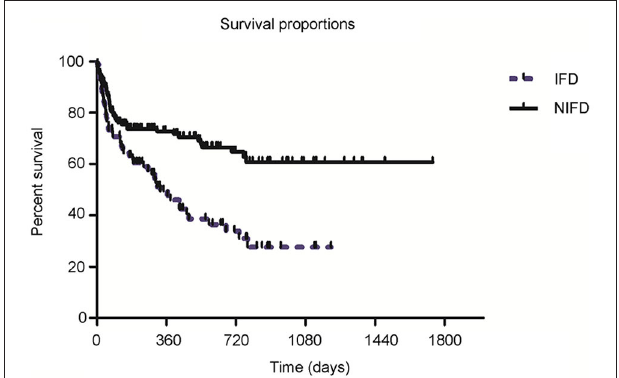
FIGURE 2 | Timing of the diagnosis of invasive fungal disease (IFD). The median time after transplantation at which the diagnosis of IFD was made was 168 days (range, 0–720 days) for invasive pulmonary aspergillosis, 31.5 days (range, 0–165 days) for invasive candidiasis, and 333 days (range, 40–465) days for Pneumocystis jiroveci pneumonia.